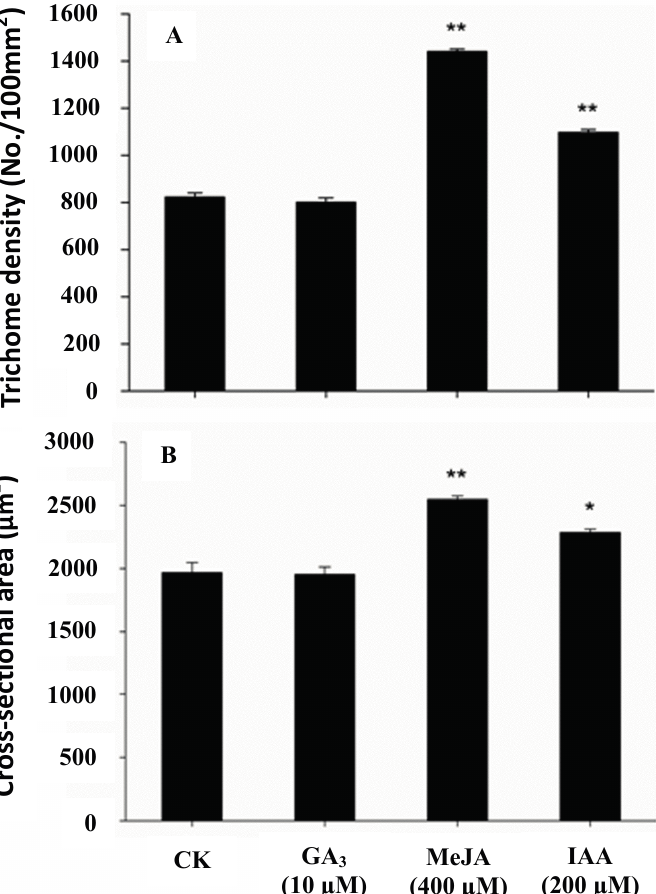
Figure 2. The effects of phytohormonal treatments on the density and size of glandular trichomes on X. strumarium L . young leaves. Bars are standard errors. Asterisks indicate significant differences. * p < 0. 05, ** p <